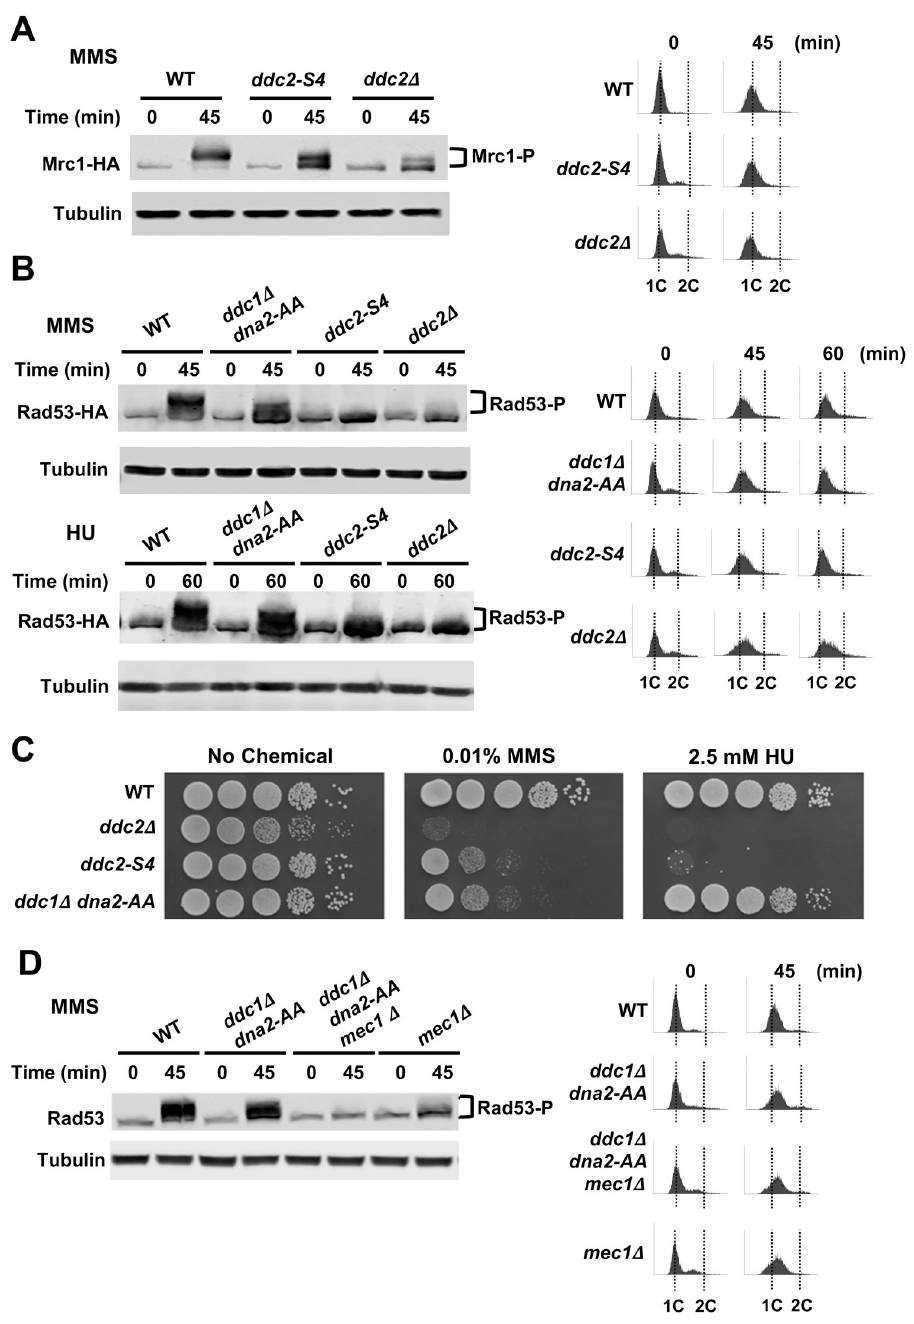
Fig 4. Effect of ddc2-S4 mutation on S-phase checkpoint signaling. (A) Wild-type (KSC4233), ddc2-S4 (KSC4234) and ddc2 Δ (KSC4235) cells expressing Mrc1-HA were arrested with α -factor at G1 and released into medium containing 0.05% MMS. Cells were collected at the indicated time and analyzed as in Fig 1A. Cell cycle progression from G1 to S phase was monitored by DNA flow cytometry. (B) Wild-type (KSC1178), ddc1 Δ dna2-AA (KSC4219), ddc2-S4 (KSC3153) and ddc2 Δ (KSC1234) cells carrying the YCpT-Rad53-HA plasmid were synchronized with α - factor at G1 and released into medium containing 0.05% MMS or 100 mM HU. Cells were collected at the indicated time (45 min for MMS and 60 min for HU) and analyzed as in Fig 4A. (C) Effect of ddc1 Δ dna2-AA or ddc2-S4 on sensitivities to MMS and HU. Wild-type (KSC1178), ddc1 Δ dna2-AA (KSC4219), ddc2-S4 (KSC3153) and ddc2 Δ (KSC1234) cells were serially diluted and spotted on plates medium containing MMS or HU. (D) Wild-type (KSC1178), ddc1 Δ dna2-AA (KSC4219), ddc1 Δ dna2-AA mec1 Δ (KSC4238) or mec1 Δ (KSC1186) cells were synchronized with α -factor at G1 and released into medium containing 0.05% MMS. Cells were collected at the indicated time and subjected to immunoblotting analysis with anti-Rad53 or anti-tubulin antibody. Cell cycle progression from G1 to S phase was monitored by DNA flow